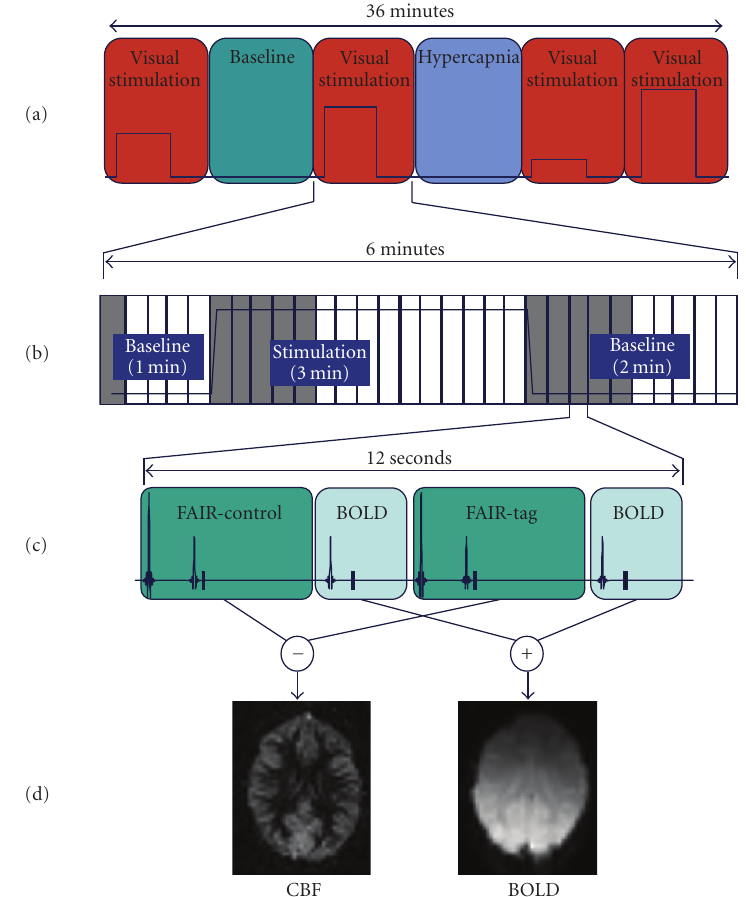
Figure 1: (a) The fMRI experimental protocol consisted of 6 randomly presented sessions (baseline, hypercapnia, and 4 levels of visual stimulation). (b) The interleaved BOLD-FAIR sequence was repeated 30 times during each run of 6 minutes, composed of a 1-minute baseline, 3-minute stimulation, and 2-minute baseline period. Scans shaded in grey (1 minute post onset and cessation of stimulation plus first scan in the run) were excluded in percent change calculations to ensure that time-averaged data included only physiological changes in steady state. (c) The basic structure of the BOLD-FAIR sequence consists of 2 BOLD acquisitions (averaged to form 1 BOLD-contrast image) interleaved with 1 slice selective and 1 nonselective ASL acquisition. (d) These 4 acquisitions produce a flow-weighted FAIR image through subtraction and a BOLD image through